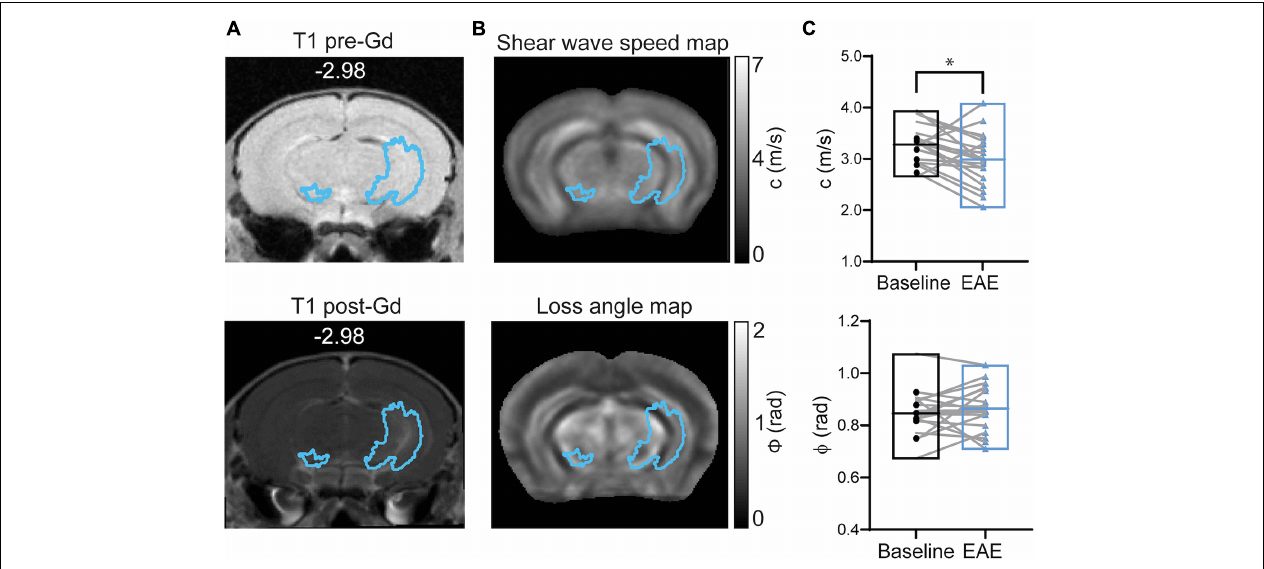
FIGURE 5 | Brain mechanical properties in Gd-enhanced lesions during EAE. (A) Representative T1-weighted image acquired before (left) and after GBCA (right) injection (corresponding GBCA mask overlaid) shows Gd-enhancing lesions near the left hippocampal artery. (B) GBCA mask overlaid on averaged MRE maps of stiffness (shear wave speed) and fluidity (loss angle). (C) Stiffness represented by shear wave speed (c) was reduced during EAE ( p = 0.0183; paired t -test) whereas tissue fluidity ( φ ) was unchanged ( p = 0.3683; paired t test). n = 19; mean, min/max; ∗ < 0.05. Of note, ventricles are excluded from our analysis since MRE cannot be performed in fluid